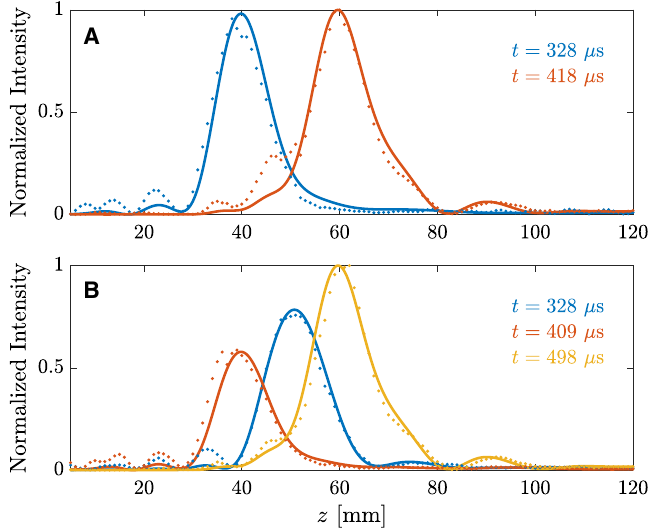
Figure 3. Steady focusing profiles: ( A ) two foci waveform and ( B ) three foci waveform. Solid lines represent simulation results, while dots represent experimental measurements.